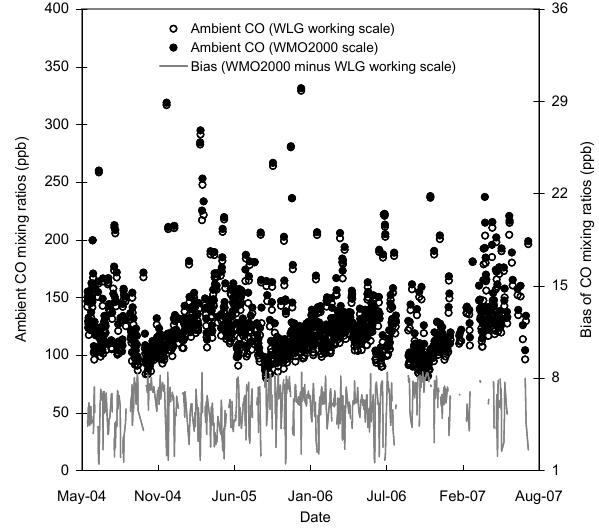
Fig. 3. Overlay of the revised (black dots) and original (white cir- cles) daily averages of CO; the gray line shows the bias of the orig- inal data which indicates a bias of the WLG working scale relative to the WMO2000